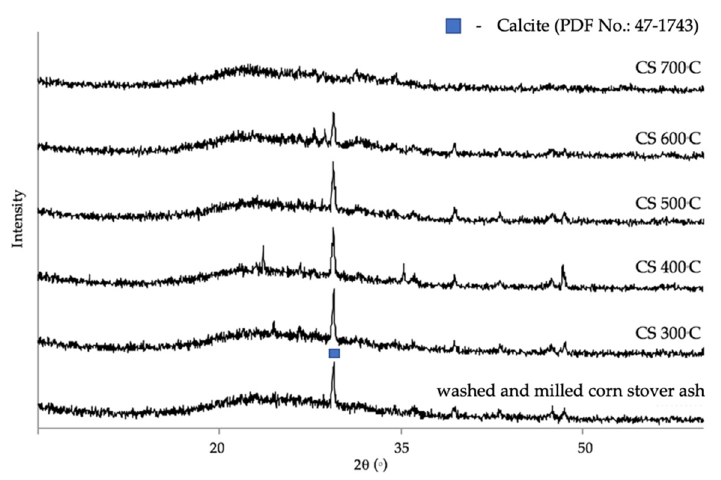
Figure 6. The XRD patterns of corn stover ash under different calcination